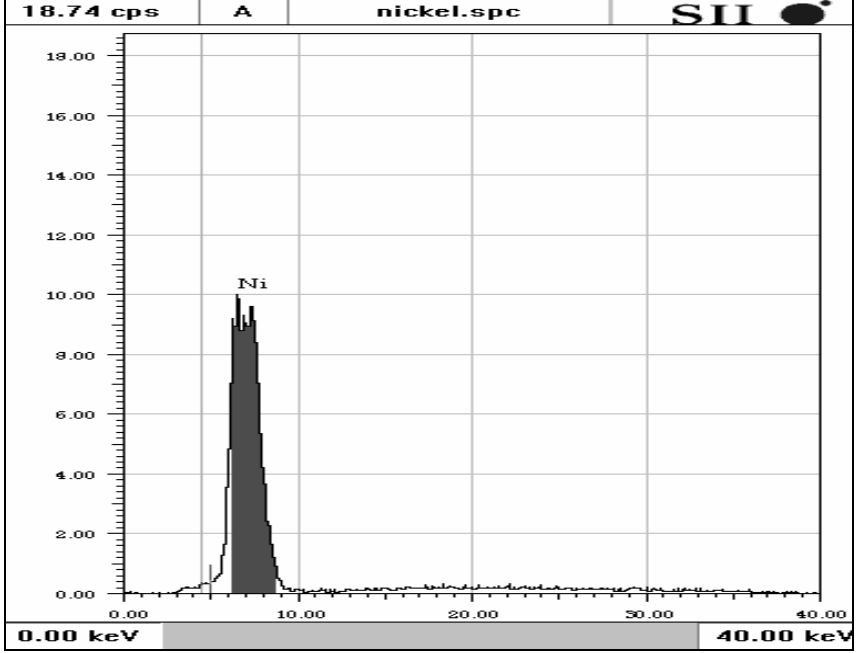
Figure 3. XRF spectrum of the nickel coating on mild steel